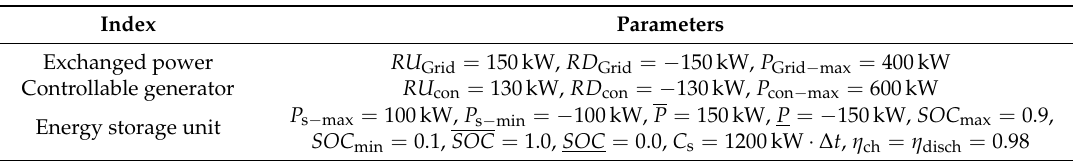
Table 1. Parameters in adaptively constrained MPC